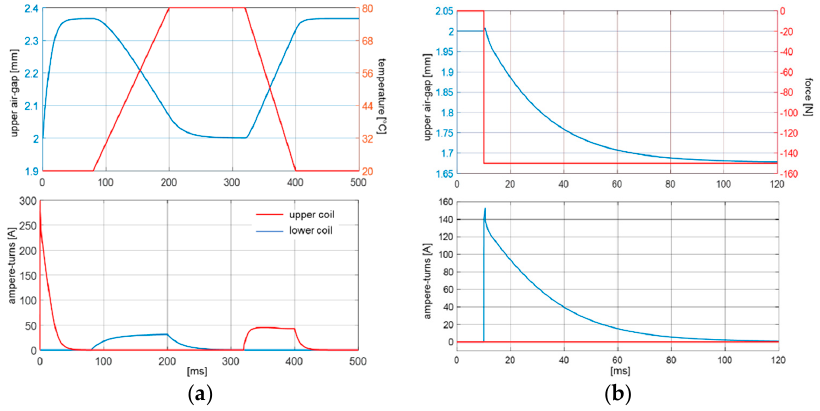
Figure 16. Dynamic progress of the air-gap and of the coil ampere-turns; ( a ) trapezoidal time variation of the temperature between θ min and θ max ; ( b ) step force disturbance F zd = − 150 N.